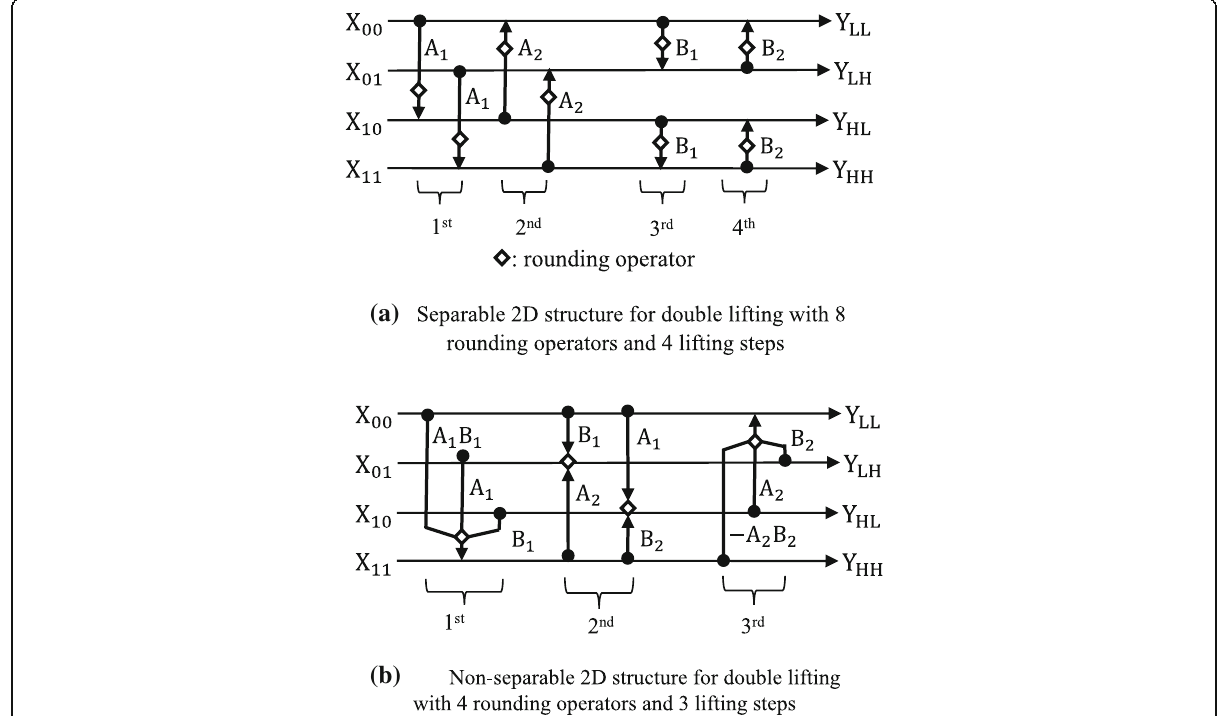
Fig. 10 Separable and non-separable 2D structures. a Separable 2D structure for double lifting with eight rounding operators and four lifting steps. b Non-separable 2D structure for double lifting with four rounding operators and three lifting steps